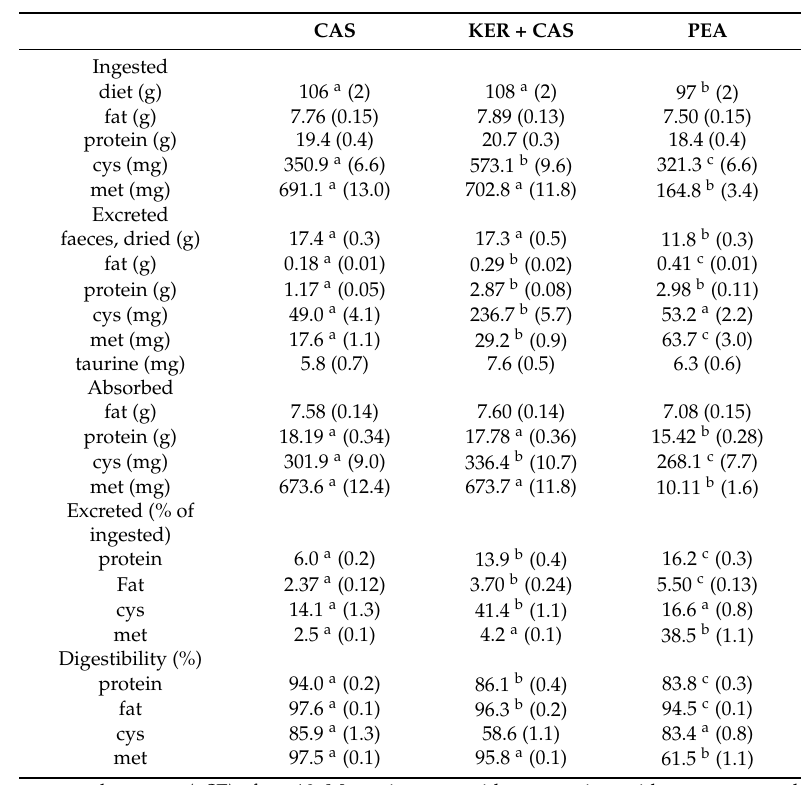
Table 5. Digestibilities of protein and amino acids in rats fed for 4 days in metabolic cages with test diets containing 18% w/w protein sourced from casein (CAS), 50:50 w/w keratin and casein (KER + CAS), or yellow pea flour (PEA) 1